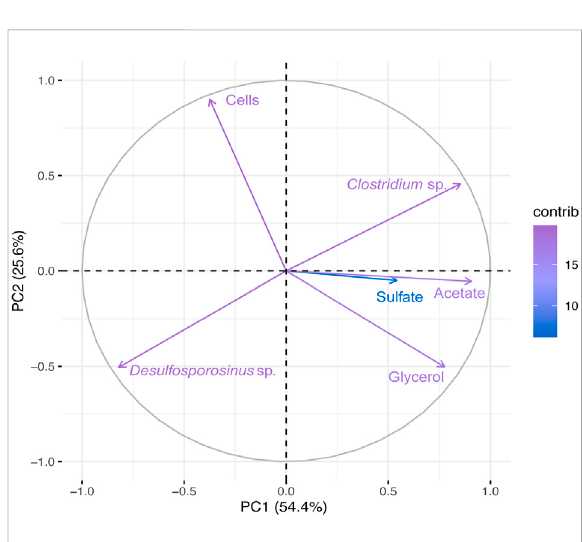
FIGURE 3 Principal Component Analyses (PCA) of the total bacterial community based on 16S rRNA gene sequences and physical- chemical analysis data from Bio I. First principal coordinates (PC1 54.4%) and the second principal coordinates (PC2